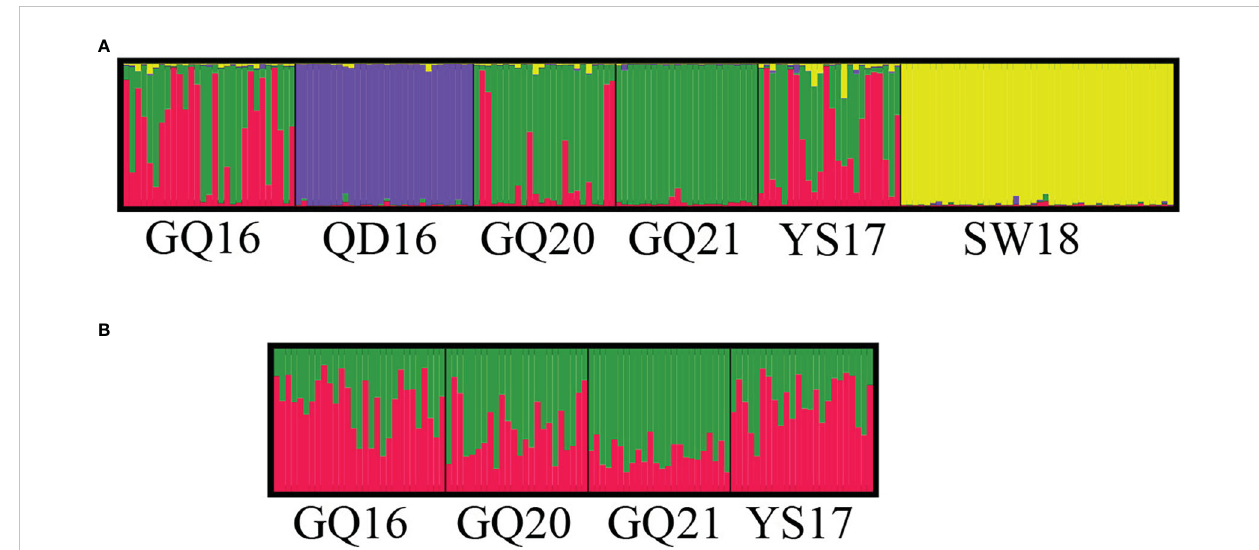
FIGURE 2 The genetic structure of (A) four native populations of Undaria pinnati fi da from southern China and two subtidal natural populations from northern China, and (B) only four southern native populations, estimated using the STRUCTURE program. The vertical colored bars represent individuals within the population and the proportion of the color of each bar indicates the probability of membership in the corresponding